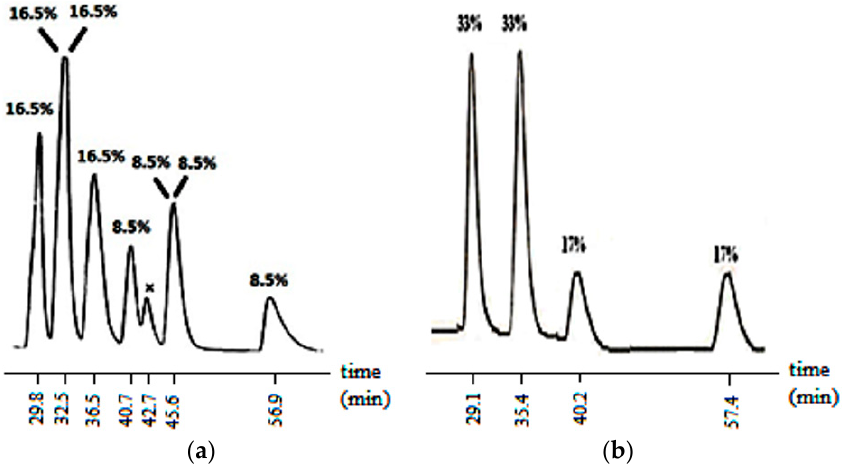
Figure 2. HPLC chromatogram of 7 showing the isomer compositions ( a ) at the end of reaction (without purification, x: impurity a ; ( b ) when the aldol reaction was carried out on a single stereoisomer of 2 . (Column: Chiralpak IB, Eluent ( v / v ) hexane:ethanol: 95:5, flow rate: 0.7 mL/min). a X was confirmed to be an impurity because it was absent in the HPLC of the purified product.